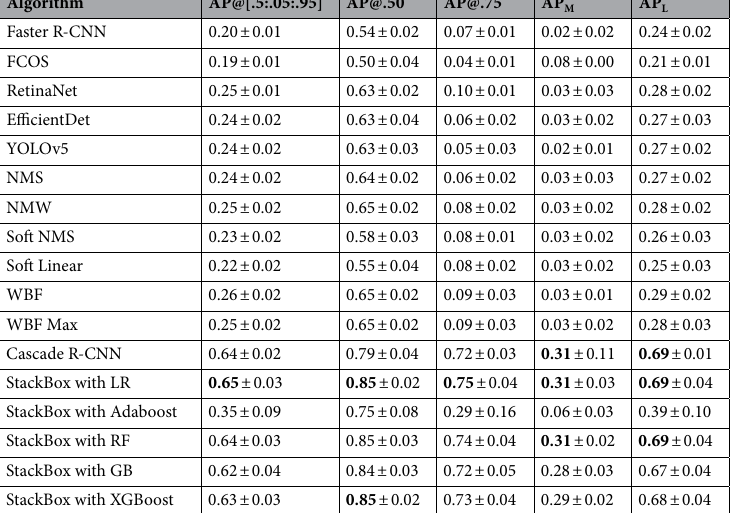
Table 1. Model comparison in terms of precision. The results present the average values obtained by combining the 5 folds ± SD of those results. AP@[.5:.05:.95] computes the average precision with 10 different IoU thresholds and takes the average among all computed results. In AP@.50 and AP@.75, the interpolation is performed in N = 101 recall points, and the first uses an IoU threshold equal to 0.5, whereas the second uses a threshold of 0.75. AP M only evaluates medium-sized ground-truth objects, whereas AP L only evaluates large ground-truth objects 38 . Bold denotes the highest values for each metric. The StackBox with Logistic Regression stands as the best model for all the metrics under consideration.